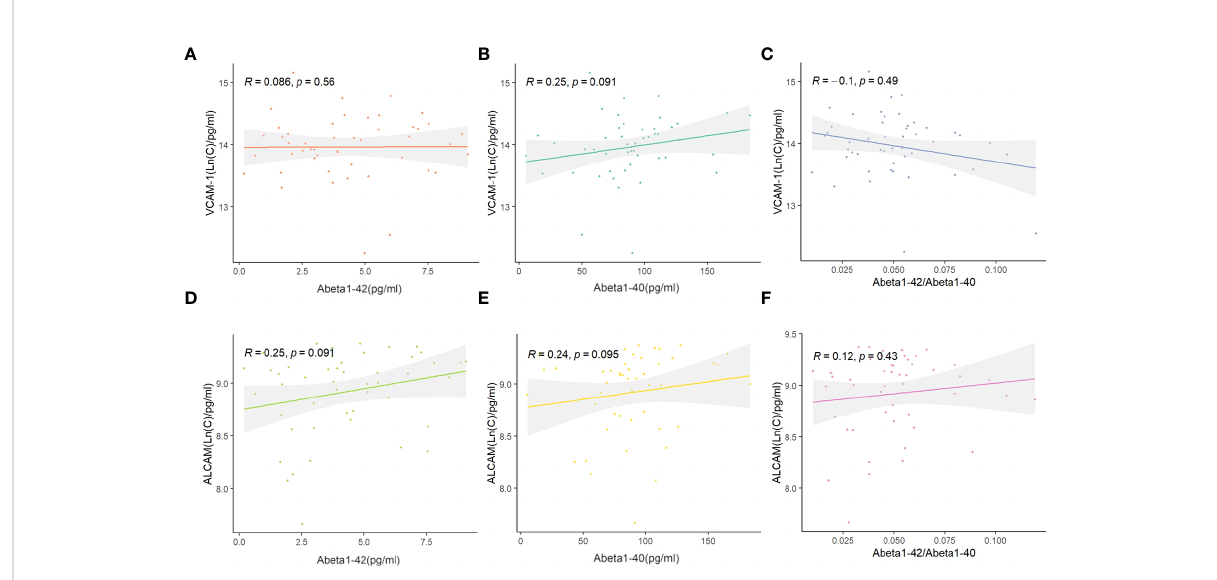
FIGURE 4 The correlation between ALCAM, VCAM-1, and Abeta1-40, Abeta1-42, Abeta1-40/Abeta1-42 in participants with AD: (A – C) Spearmen correlation analysis demonstrated that VCAM-1 was not signi fi cantly correlated with Abeta1-42 (p-value > 0.05, A ), Abeta1-40 (p-value > 0.05, B ) and Abeta1-40/Abeta1-42 (p-value > 0.05, C ). (D – F) Spearmen correlation analysis demonstrated that ALCAM was not signi fi cantly correlated with Abeta1-42 (p-value > 0.05, D ), Abeta1-40 (p-value > 0.05, E ) and Abeta1-40/Abeta1-42 (p-value > 0.05, F